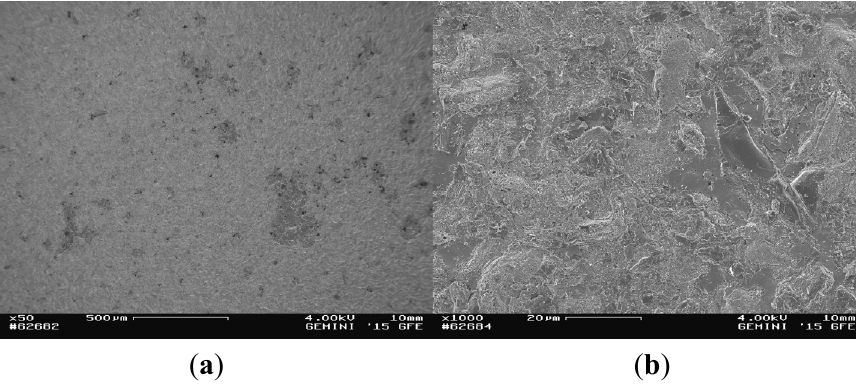
Figure 9. SEM images of the fractured surface of 5_ATZ_Ti at magnifications of ×50 ( a ) and ×1000 ( b